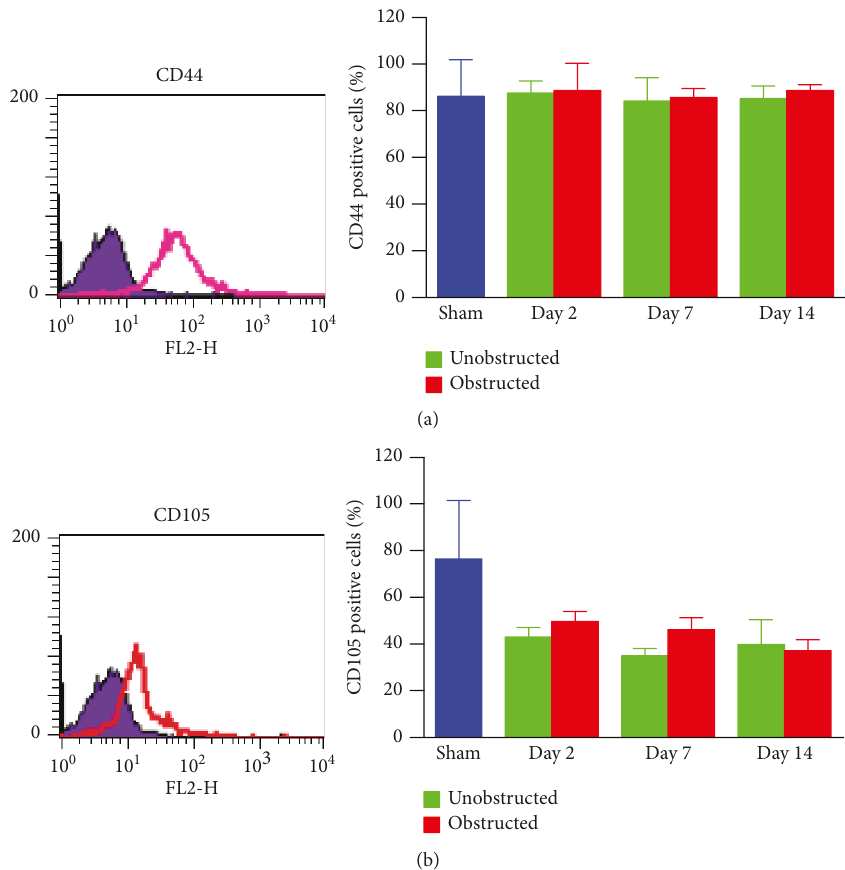
Figure 3: Expression of CD44 and CD105 in the ex vivo expanded cells from renal tissues. Twice-passaged cells are used for measuring the expression of CD44 (a) and CD105 (b) by fl ow cytometry. The representative histograms (left) and quantitative data (right) are